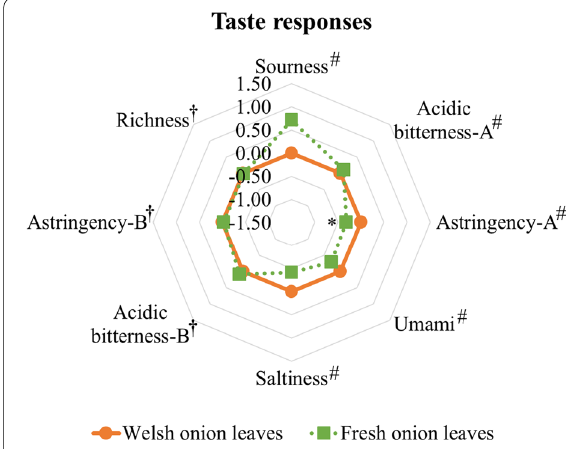
Fig. 1 Taste responses in leaves of Welsh onion and fresh onion. # Initial taste, † Aftertaste. Values are expressed as fold change relative to Welsh onion leaves each taste (Welsh onion leaves the mean ( n 5). * p < 0.05 (Welch’s t test), compared between Welsh = onion leaves and flesh onion leaves in each taste